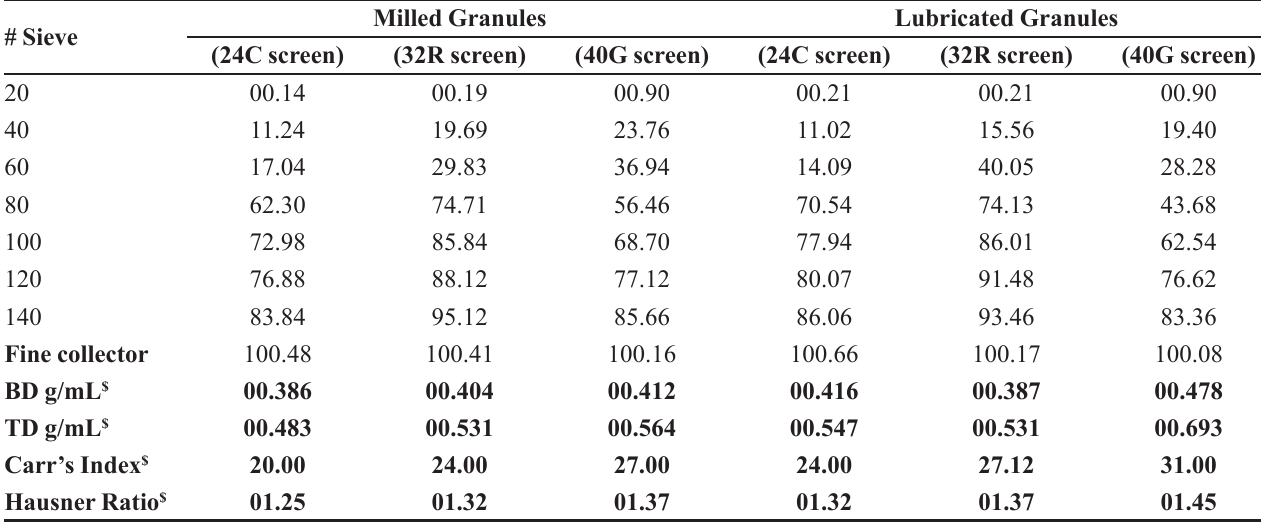
TABLE III - Particle size distribution data (Cumulative % weight retained) # Sieve